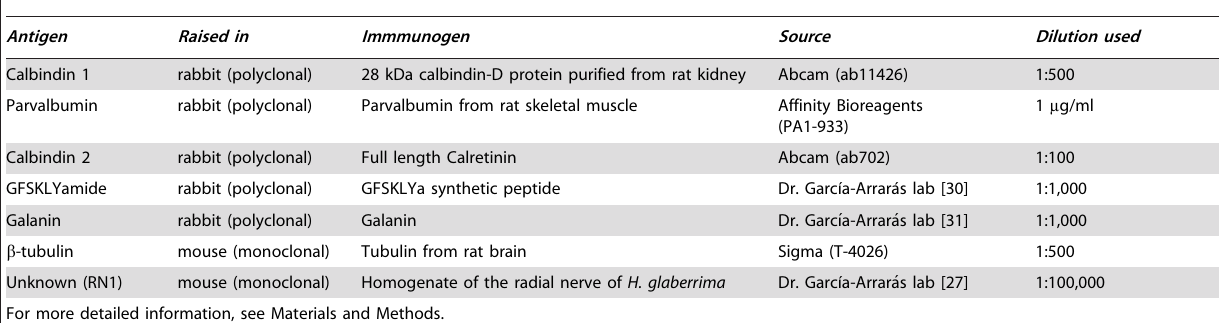
Table 1. Antibodies used in this